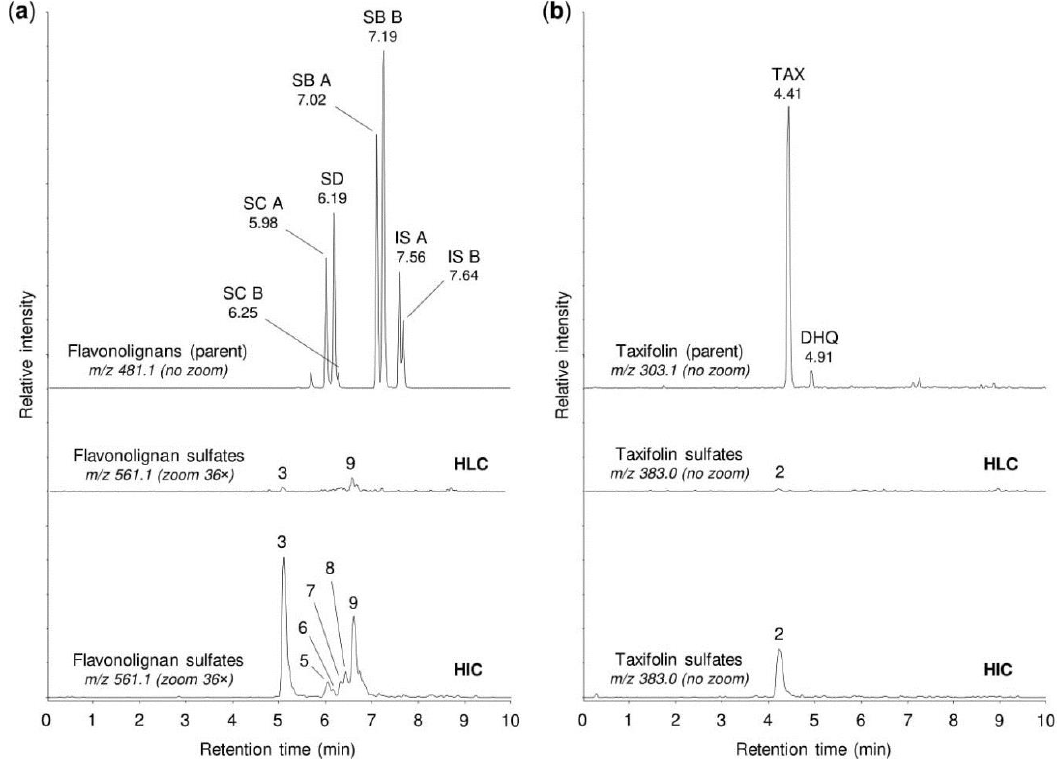
Figure 3. Sulfation of silymarin mixture by human tissue cytosols. Silymarin (50 µ M) was incubated for 30 min with pooled human liver cytosol (HLC) or pooled human intestinal cytosol (HIC), then analyzed by the UHPLC-MS method. ( a ) The representative chromatograms show the parent flavonolignans, i.e., silydianin (SD), silychristin A (SC A), silychristin B (SC B), silybin A (SB A), silybin B (SB B), isosilybin A (IS A), and isosilybin B (IS B), along with their sulfation products. ( b ) The representative chromatograms show the parent taxifolin (TAX), a dihydroquercetin isomer (DHQ), and their sulfation products. The peaks of sulfates are marked with numbers corresponding to those in Figure 2. For details